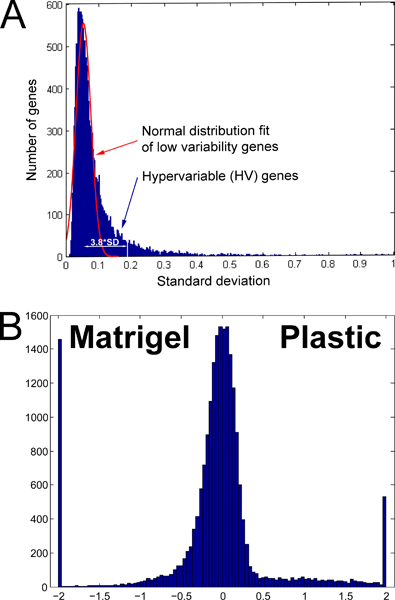
Identification of hypervariable and differentially expressed genes. A) Frequency histogram of variances of genes across timecourse. The normal distribution of low-variable genes identified from the left part of the histogram; the white vertical line marks the threshold for hypervariable genes expressed 3.8 SD above distribution of constant genes expressing only technical variability. B) Log10 ratio of average gene expression of cells grown on plastic and crECM is presented as a frequency histogram. Ratio values > 2 or < -2 were truncated and set to 2 and -2, respectively.